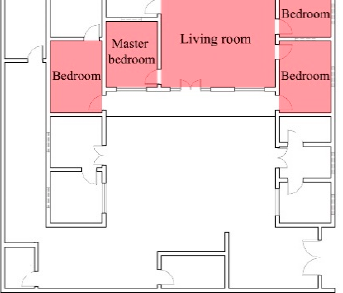
Figure 11. Rooms heated in Rural House 2.